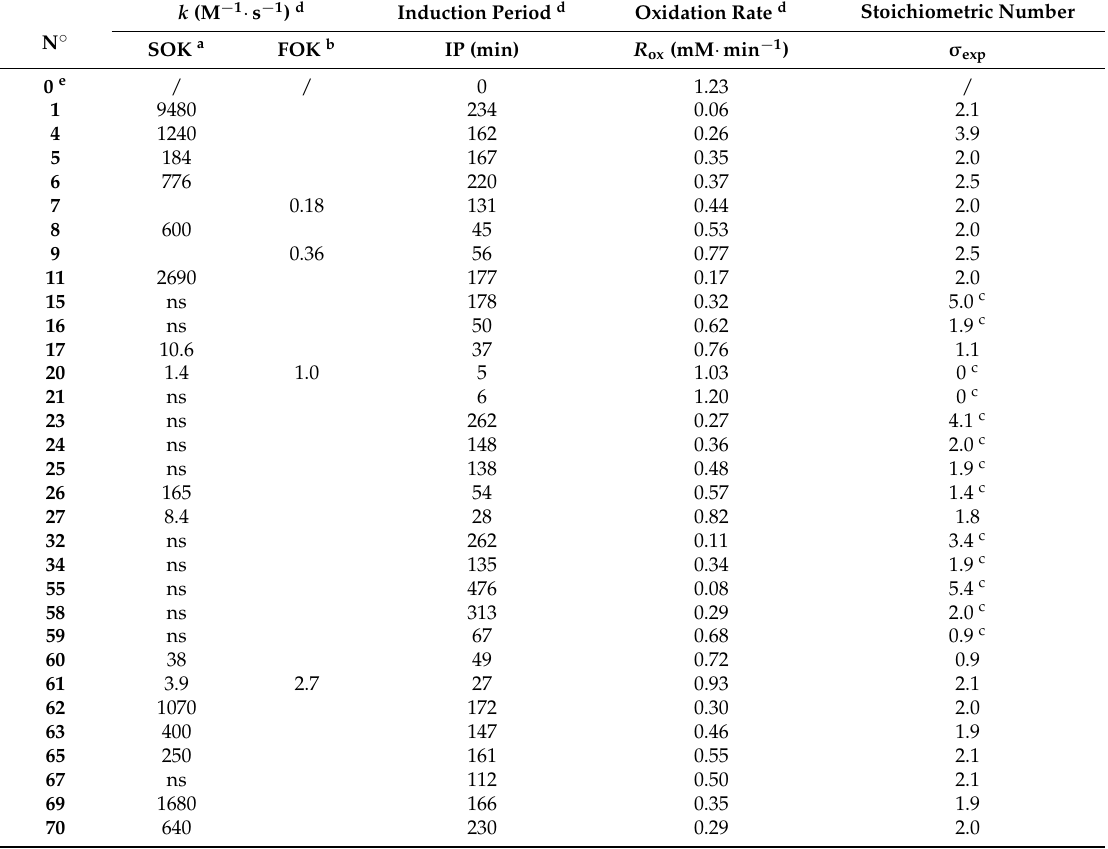
Table 3. Rate constants ( k ) of hydrogen transfer from ArOH to DPPH ‚ in toluene at 20 ˝ C, stoichiometric numbers of H atoms ( σ exp ) determined with an excess of DPPH ‚ in toluene at 20 ˝ C, induction periods (IP) and oxidation rates ( R ox ) are determined by the RapidOxy ®